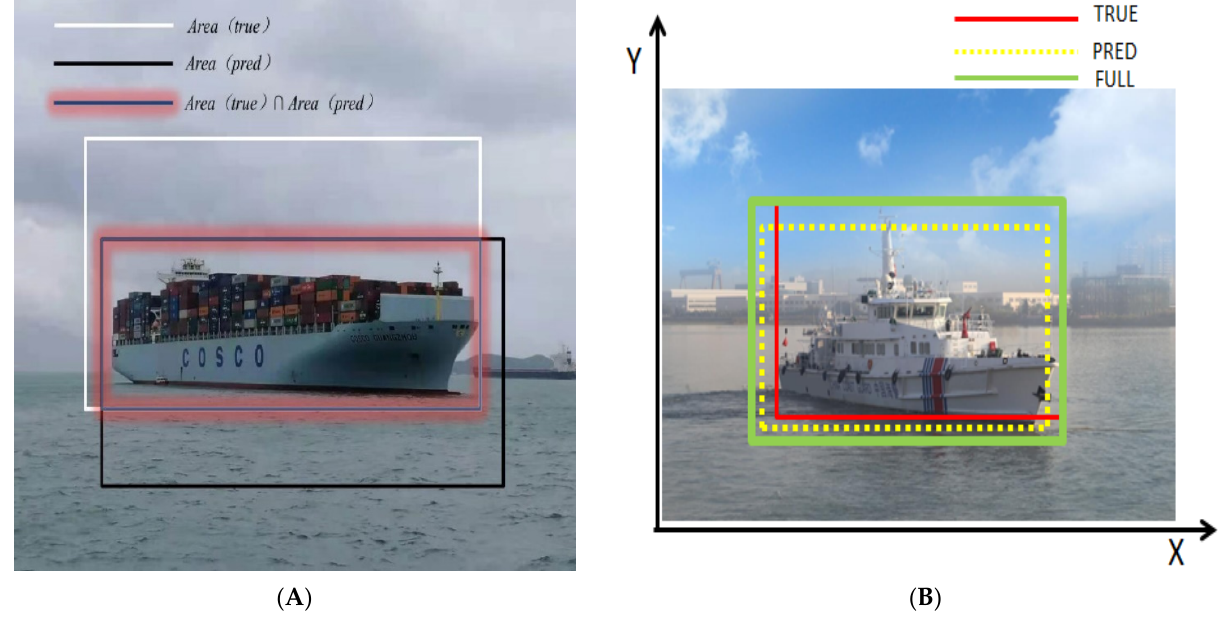
Figure 1. Schematic diagram of ( A ). IOU and ( B ). GIOU.